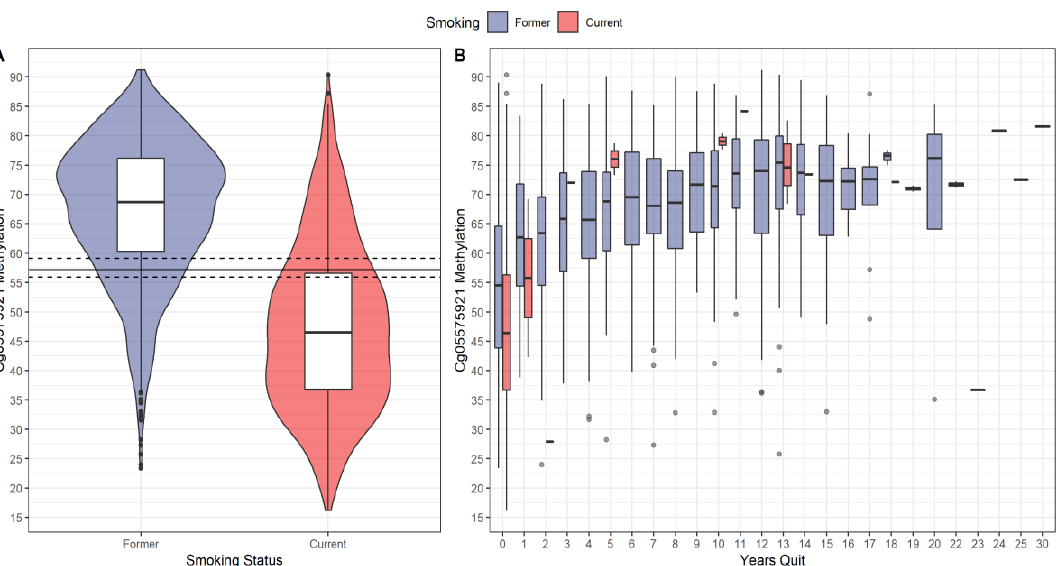
Figure 1. Distribution of cg05575921 methylation. ( A ) Boxplots wrapped by violin plots of cg05575921 methylation by self-reported smoking status. The solid horizonal line is the estimated optimal cut-point, and the dashed lines are the (asymmetric) 95% CI. ( B ) Boxplots of cg05575921 methylation as a function of smoking status and years quit (number of years since quitting cigarettes). A small number of self-reported current smokers had >0 years quit attributable to measurement error.